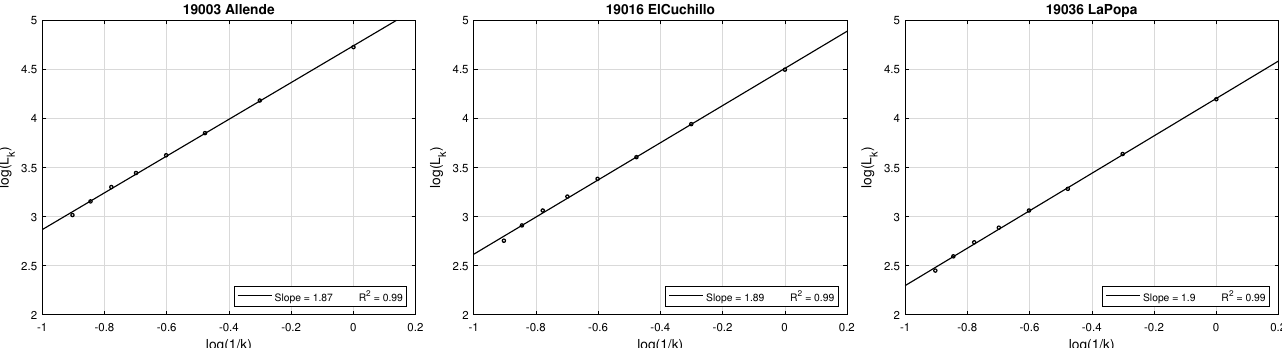
Figure 4. Calculation of HFD by fitting the slope F from Equation (10), obtaining the coefficient of determination R 2 when considering k max = 8, i.e., eight data points to fit. Table 1 contains the summary of the adjustments carried out for all the stations analyzed. For each station, the table shows its number, name, coordinates (latitude and longitude), the obtained values of Hrs and HFD , accumulated annual rainfall (A.A.R.) in mm, and climate (with colors). Results are shown in an ascending order according to